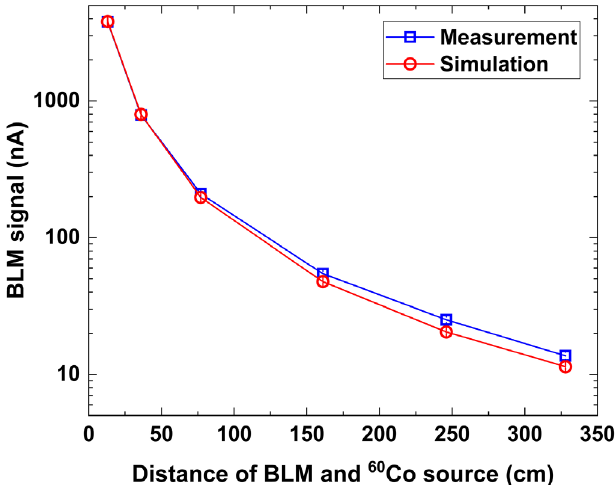
FIG. 13. The experimental and simulated BLM signal in the 60 Co radiation field at different